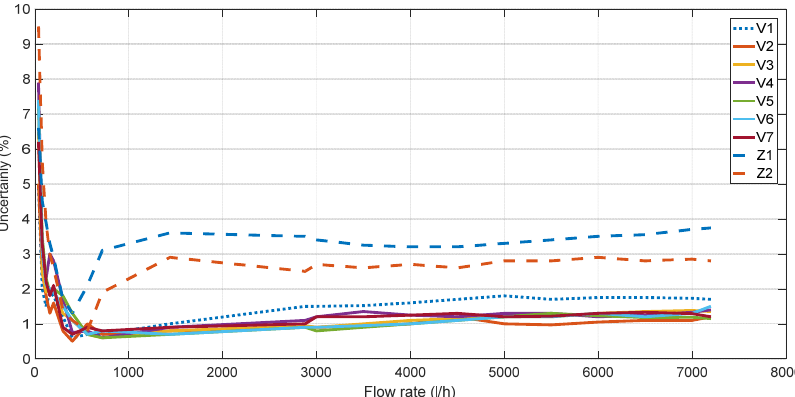
Figure 7. Uncertainty of different mechanical designs.